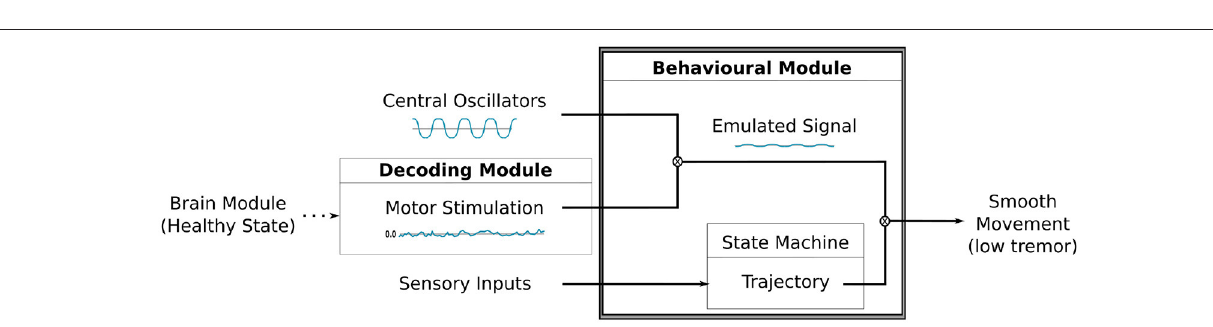
FIGURE 5 | A diagram illustrating the modulation process between the motor stimulation produced by the DM and the oscillatory signal by the Central Oscillators. The resulting signal is combined to the trajectory, defined by our state machine, to finally produce the movement on the robot’s